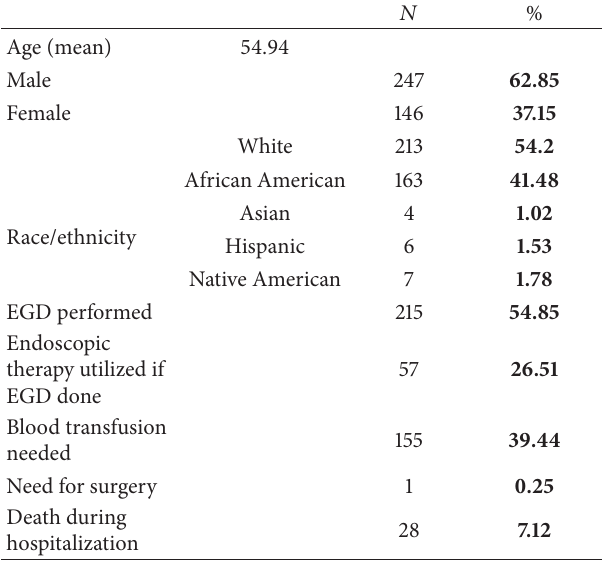
Table 3: Demographics and